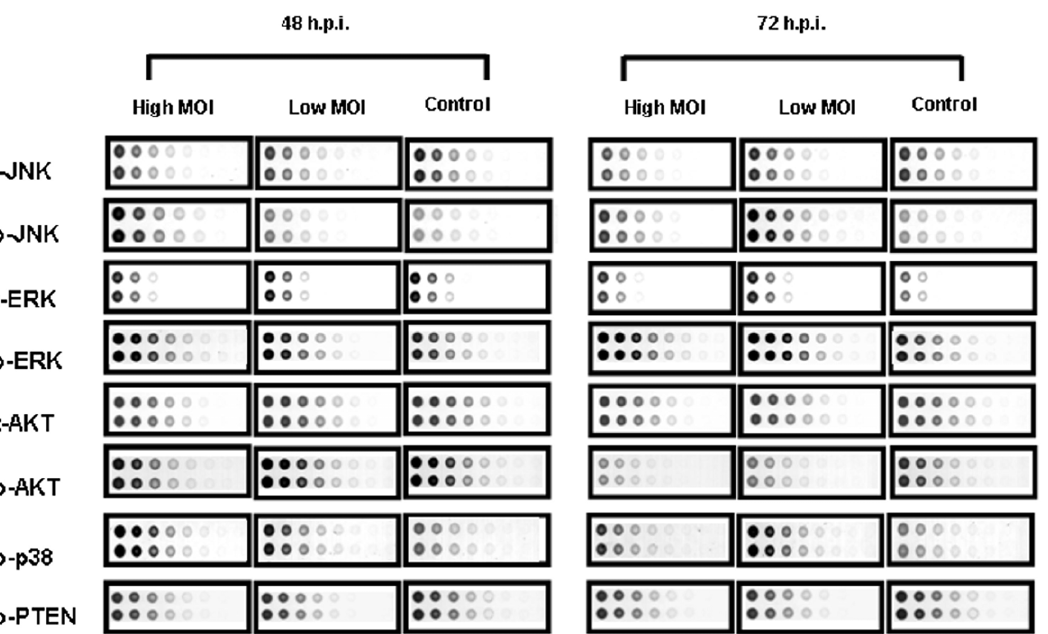
Figure 2. Example of RPMA slides stained with antibodies against total and phosphorylated forms of SAP/JNK, ERK and AKT and against phosphorylated form of p-38 and PTEN. Portions of slides stained with antibodies against total and phosphorylated protein forms are shown for untreated (Control) and RVFV-infected HSAECs at 48 and 72 h.p.i. Low and high MOI correspond to 0.0002 and 0.002, respectively. Each sample along with eight 2 6 serial dilutions was printed in duplicate. Prefixes t and p indicate the total and phosphorylated proteins,